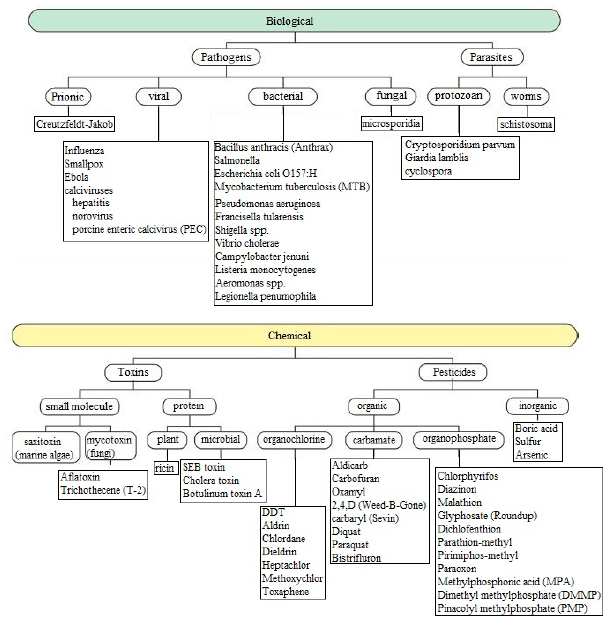
Figure 1. Representation of a hierarchical categorization of the analytes that are present in food and water [24] .